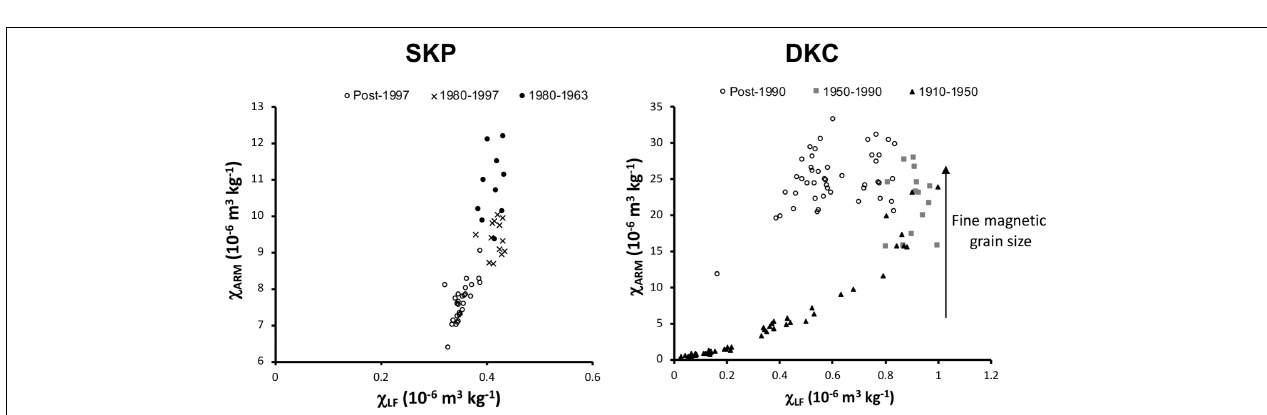
FIGURE 7 | Flux profiles for Dogs Kennel Clump Pond (DKC) showing deposition of magnetic grains (SIRM, SOFT 20 , and HARD 300 ), SCPs and identified anthropogenic geochemical tracers Ba, Cu, Pb, and Zn. Superimposed are distinct phases identified from the flux profiles, which relate to the urban history of the Merseyside region.